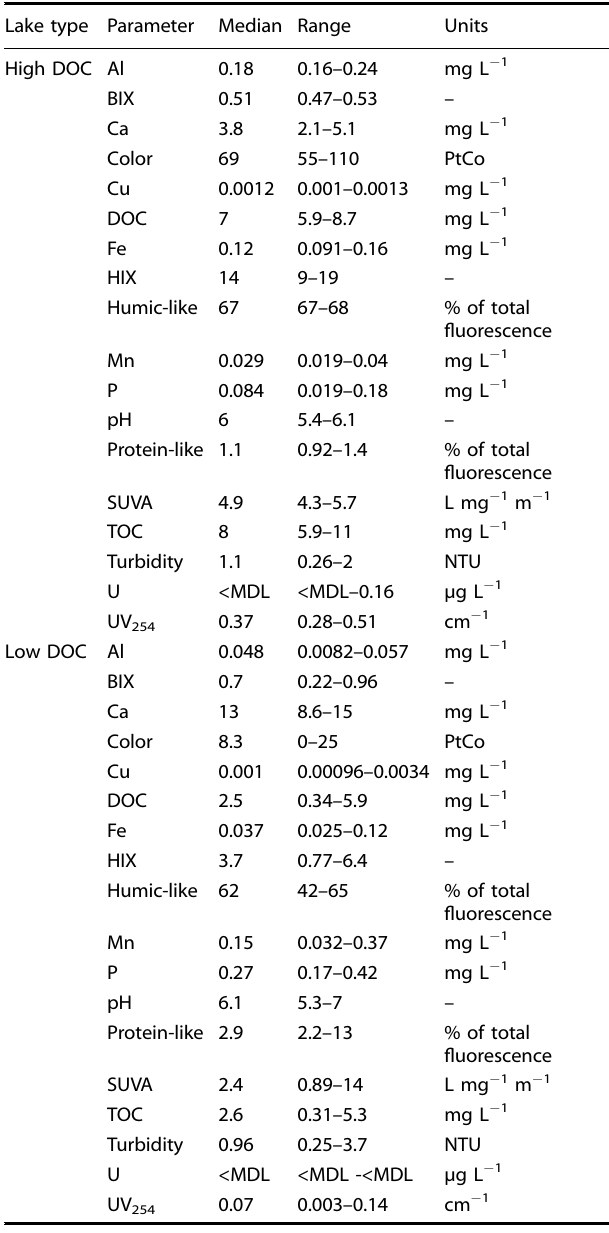
Table 1. Water quality summary of the study